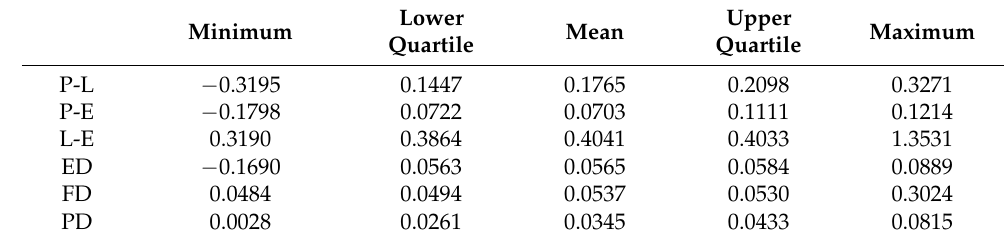
Table 4. Calculation results of the GWR model.